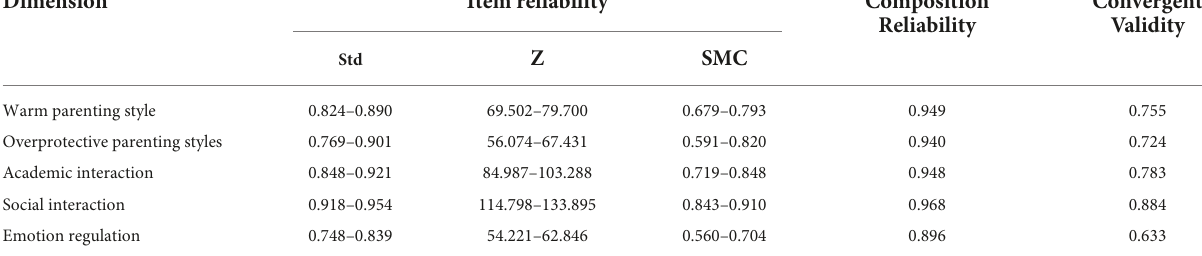
TABLE 1 Validation factor